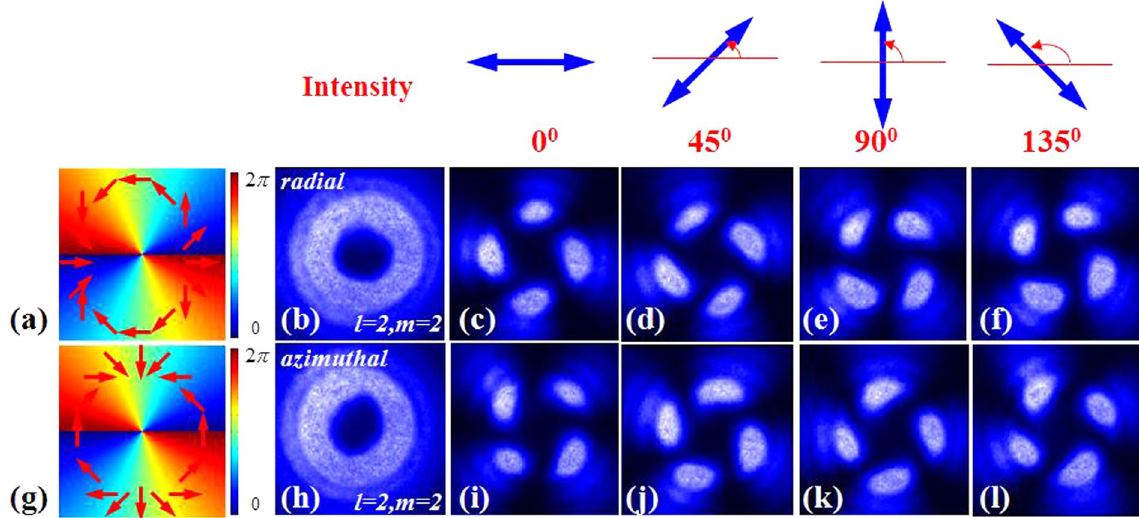
Figure 9. Experimentally generated CVV beams by cascading two metasurface and a QWP. Two different cylindrical vector polarizations of radial and azimuthal are displayed from up to down. The polarization order ( m ) and the topological charge ( l ) both were 2. The first column shows the schematic polarization distributions (red arrow diagrams) and phase distributions (periodically changing color background), of which the experimental results are presented in each row respectively. Different axis orientations of polarizer 0°, 45°, 90 0 and 135 0 (blue arrows in the first row) were selected in this experiment.